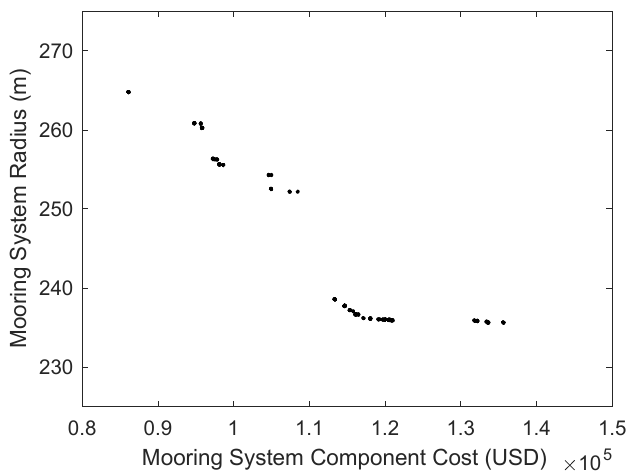
Figure 10. Designs along the Pareto-Optimal Front.